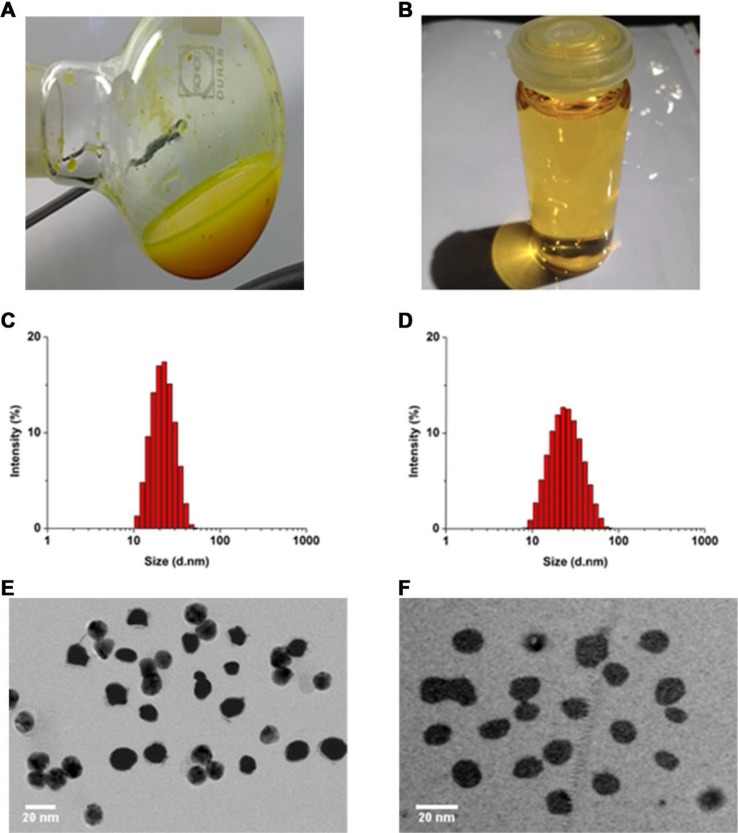
Gross appearance of nanoparticle dispersions prepared using TPGS:CCM ratios of (A) 3.5:1 and (B) 12.5:1. Sample (A) was translucent orange with visible precipitation, while (B) was transparent yellow. Size distribution of (C) MTPGS micelles and (D) 12.5:1 of TPGS/CCM micelles, based on dynamic light scattering. Transmission electron micrographs of (E) MTPGS micelles and (F) 12.5:1 of TPGS/CCM micelles. Scale bar, 20 nm.